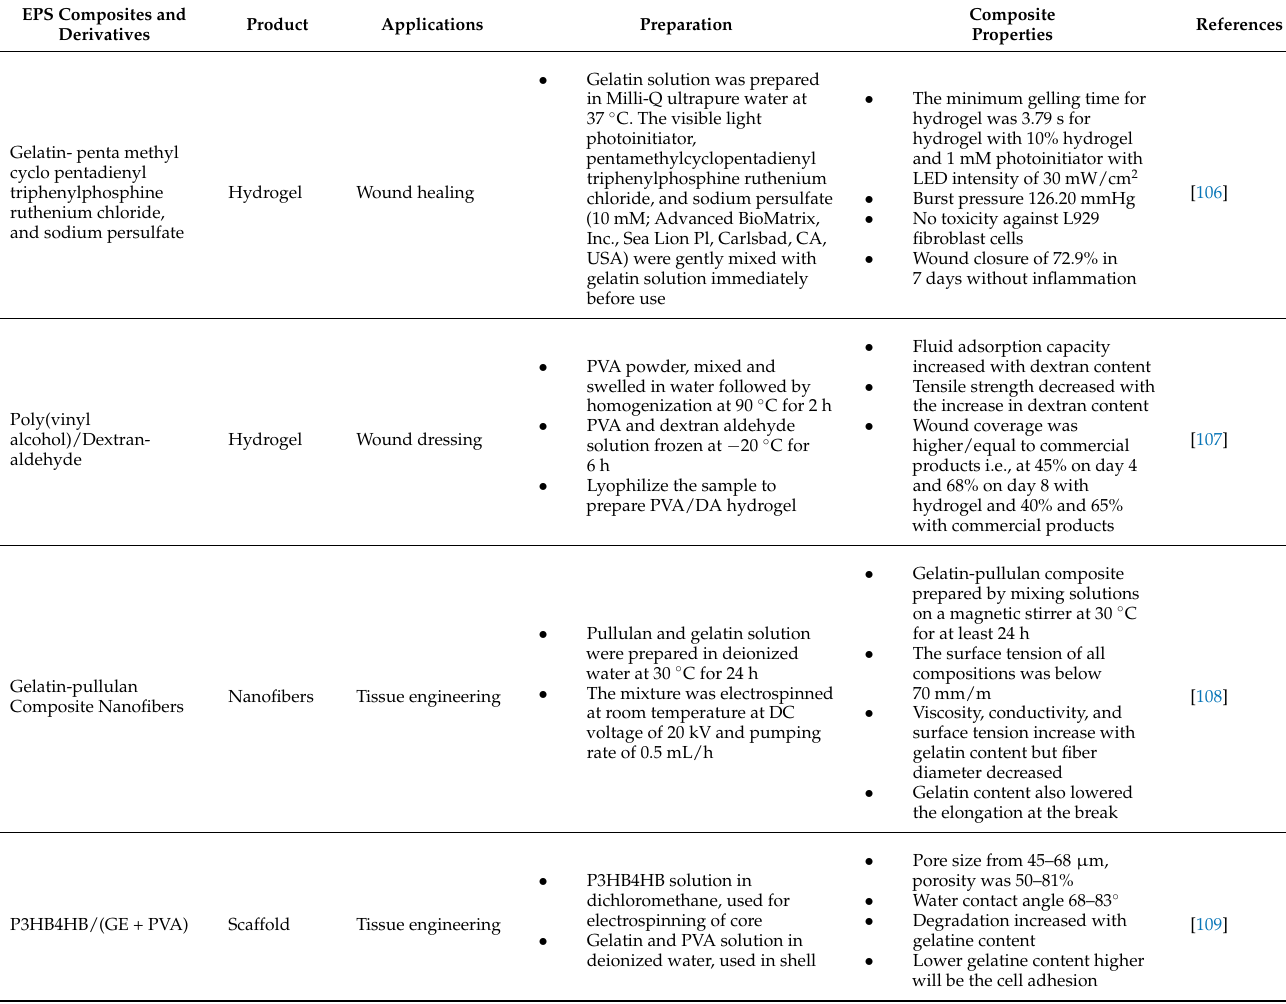
Table 2. Exopolysaccharides composites in biomedical